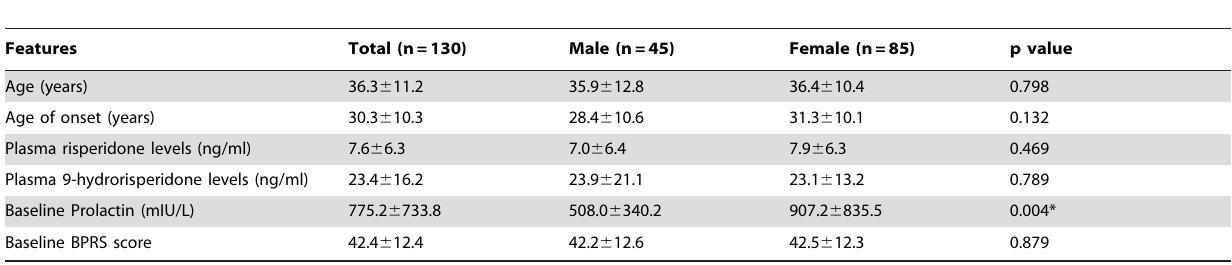
Table 3. Clinical characteristics and baseline demographics of schizophrenia patients treated with risperidone.